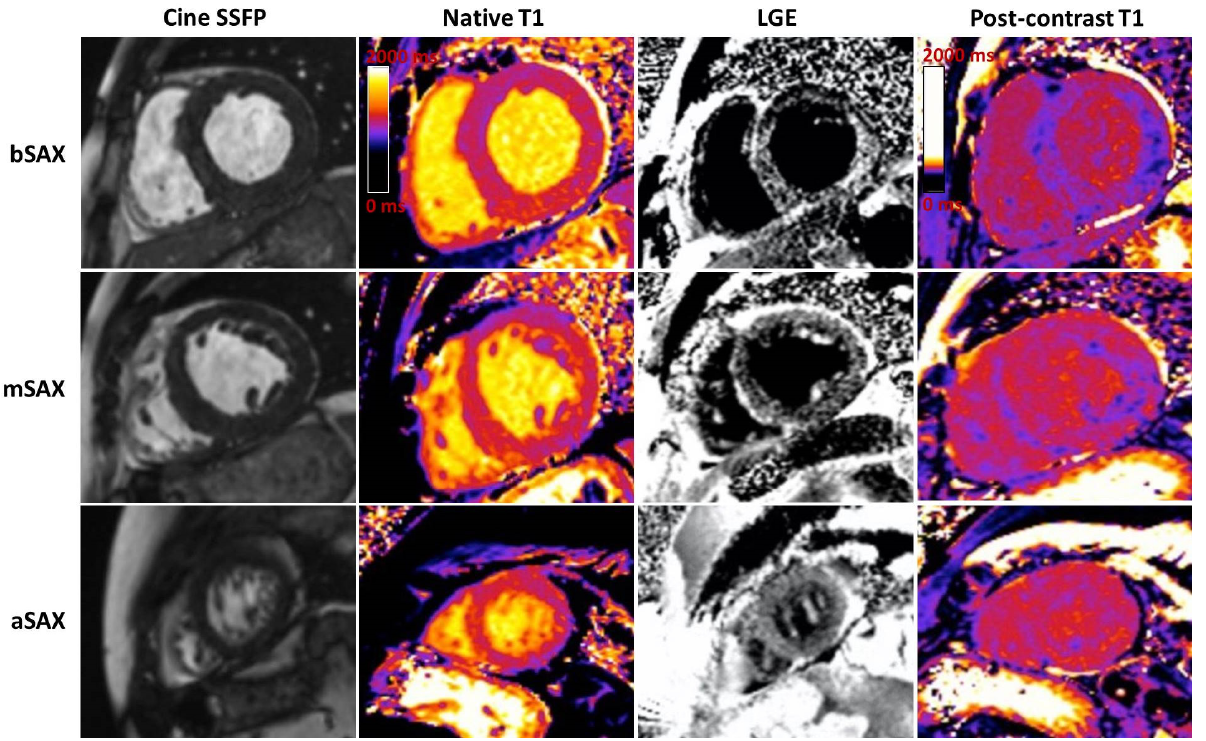
Figure 5. Typical cardiac magnetic resonance findings in a patient with ATTR cardiac amyloidosis. Short axis views at basal (bSAX), midventricular (mSAX), and apical (aSAX) levels showing concentric left ventricle hypertrophy in SSFP cine images (the first column), with diffuse elevation in native T1 mapping (the second column), transmural hyperenhancement, more pronounced at the basal and midventricular levels, with a dark blood pool in LGE images (the third column) and diffuse reduction in post-contrast T1 mapping (forth column). SSFP: Steady-state free precession; LGE: late gadolinium enhancement.